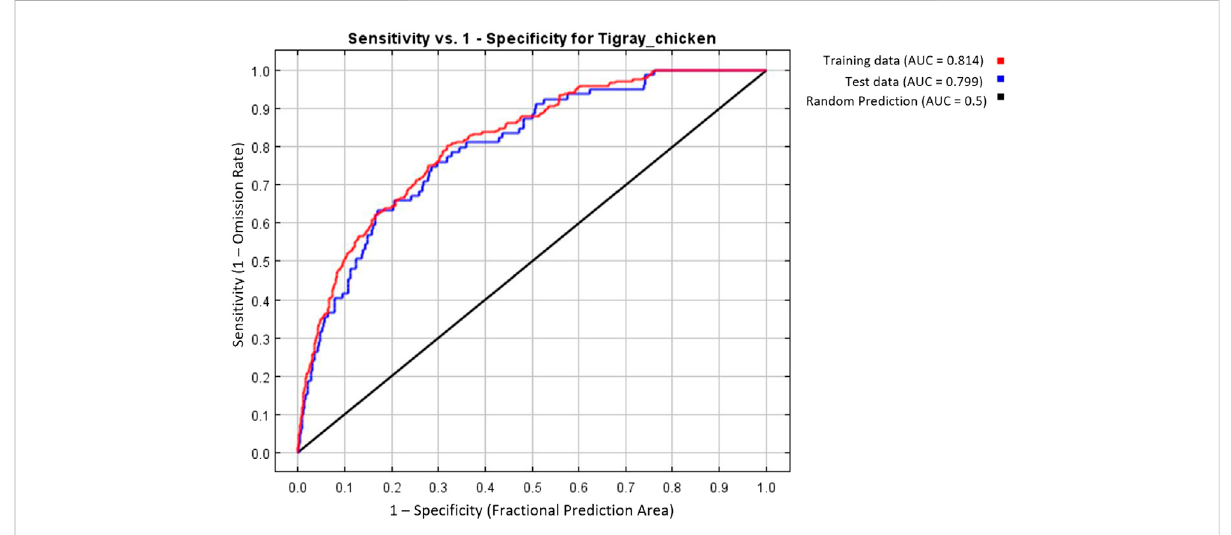
FIGURE 7 MaxEnt modelbasedonseven selectedvariablesandthebestfeature(H)andbeta-multipliervalue(two).AreaUnderReceiverOperating Curve for training and test